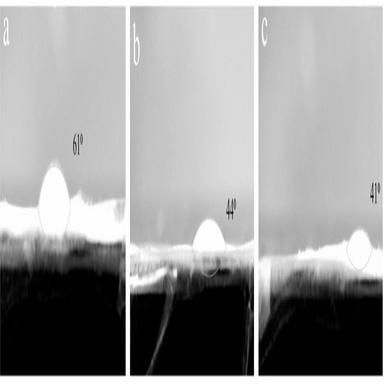
Contact angle images of a) PVP b) Av/PVP c) AvAc/PVP.